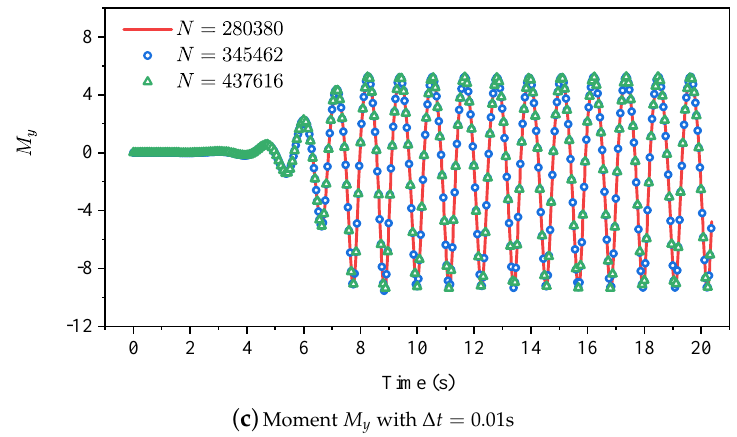
( c ) Moment M y with ∆ t = 0.01s Figure 6. Evolutionary profiles of the hydrodynamic loads F x , F z , and M y by using three numbers of computational nodes with ∆ t = 0.01s.